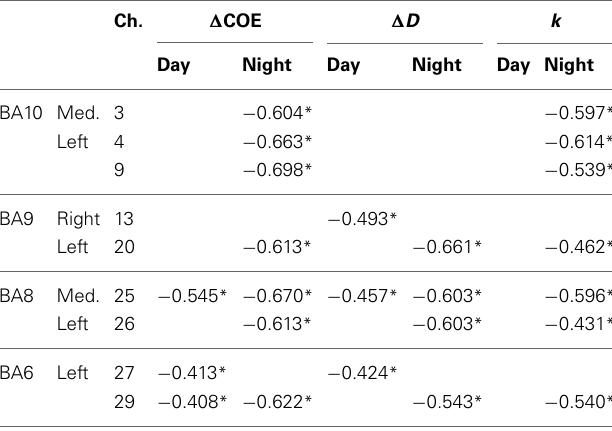
Table 3 | Positive correlations in the speed reduction task between vehicle acceleration and each of the brain activation